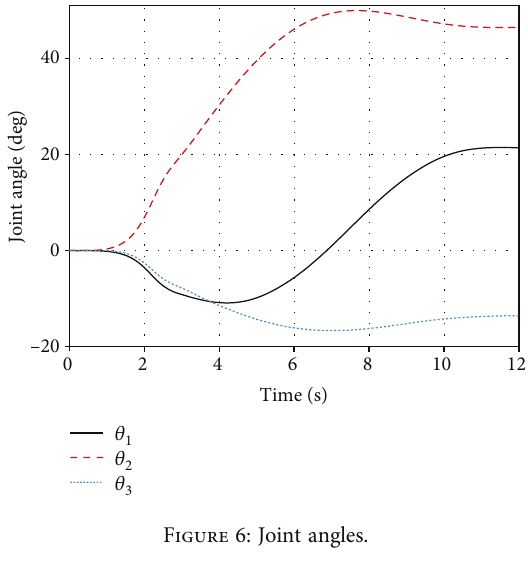
Figure 4: Output force.